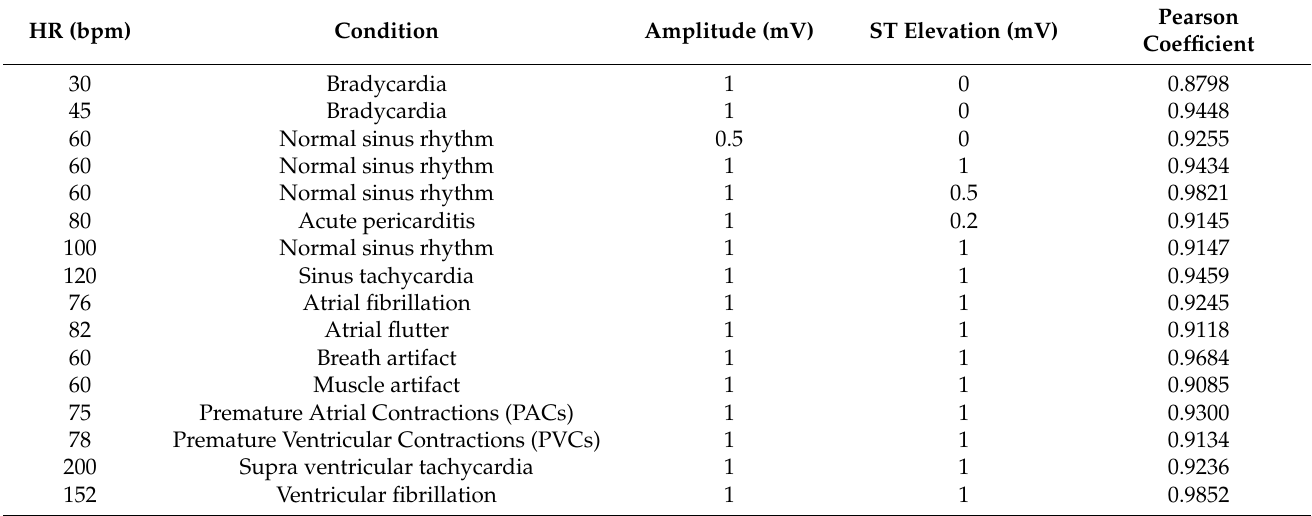
Table 2. Pearson coefficient for each condition.